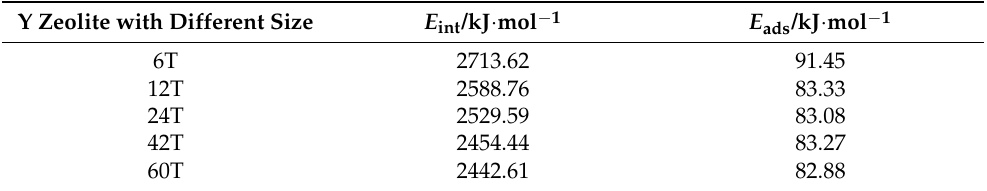
Table 1. The interaction energies ( E int ) of Cu 2+ and the adsorption energies ( E ads ) of CO on the clusters of Cu 2+ Y zeolites with different sizes.